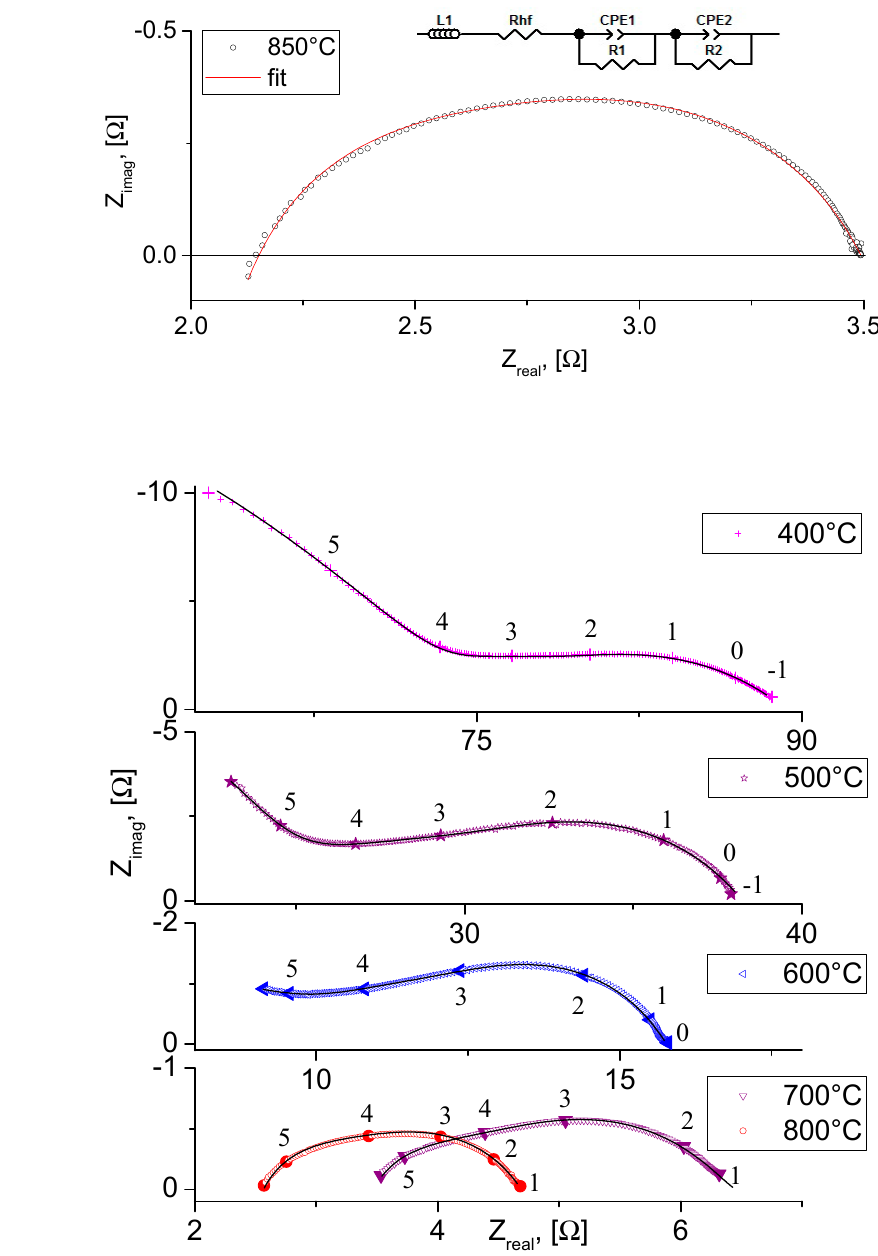
Figure 7. Typical impedance spectra of the Pt|LBNO|BCGCuO|Pt cell: ( a ) obtained at 850 °C in air; ( b ) the spectra view at different temperatures.